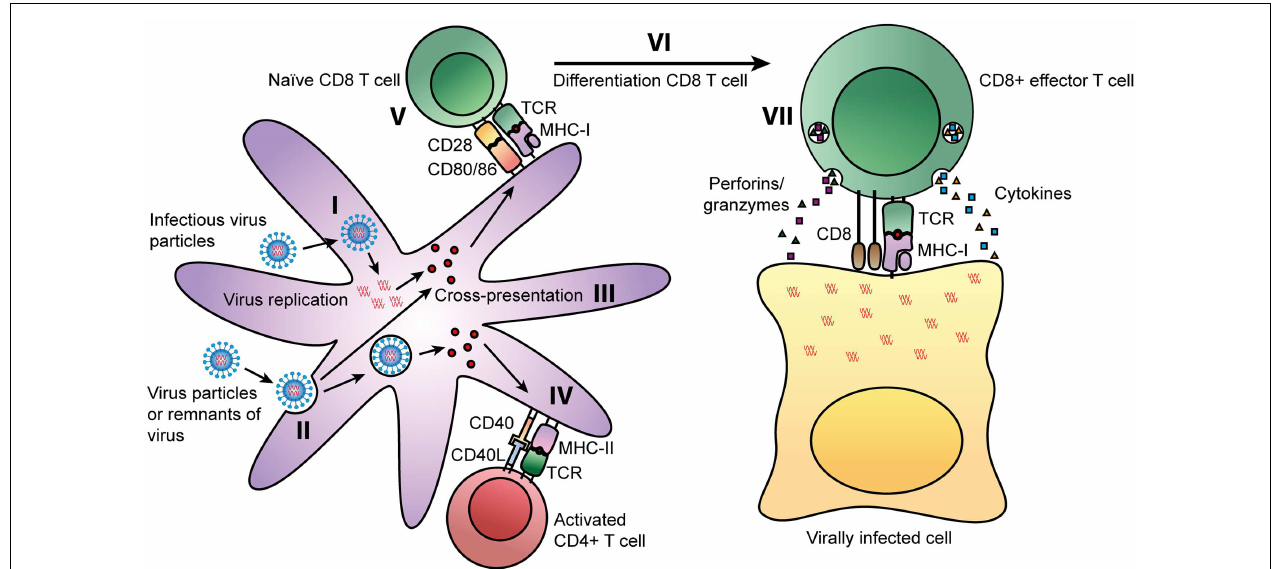
complex with theTCR, CD4 + T cells can activate DCs by interaction of CD40 with CD40 ligand on the DC (IV).This interaction activates DCs and results in upregulation of maturation markers CD80/CD86. CD80 and CD86 interact with CD28 on naïve CD8 + T cells (V).Together with the recognition of the MHC class I-peptide complex by theTCR, CD28 signaling will result in the activation of the CD8 + T cell (VI).These activated CD8 + T cells will differentiate into effectorT cells that can recognize the MHC class I-peptide complex on virally infected cells. Binding of theTCR to the MHC class I-peptide complex leads to activation of the CD8 + T cell and the release of cytotoxic granules containing perforins and granzymes, and the production of cytokines such as TNF- α and IFN- γ